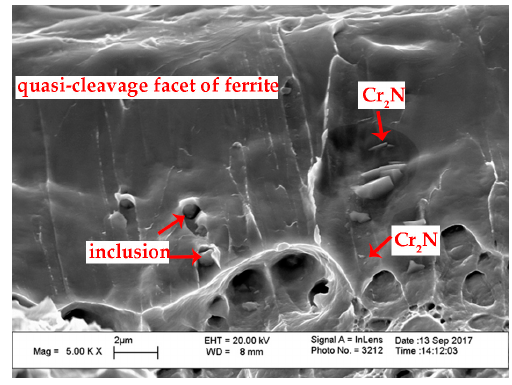
Figure 17. Chromium nitrides observed in the impact fracture surface.